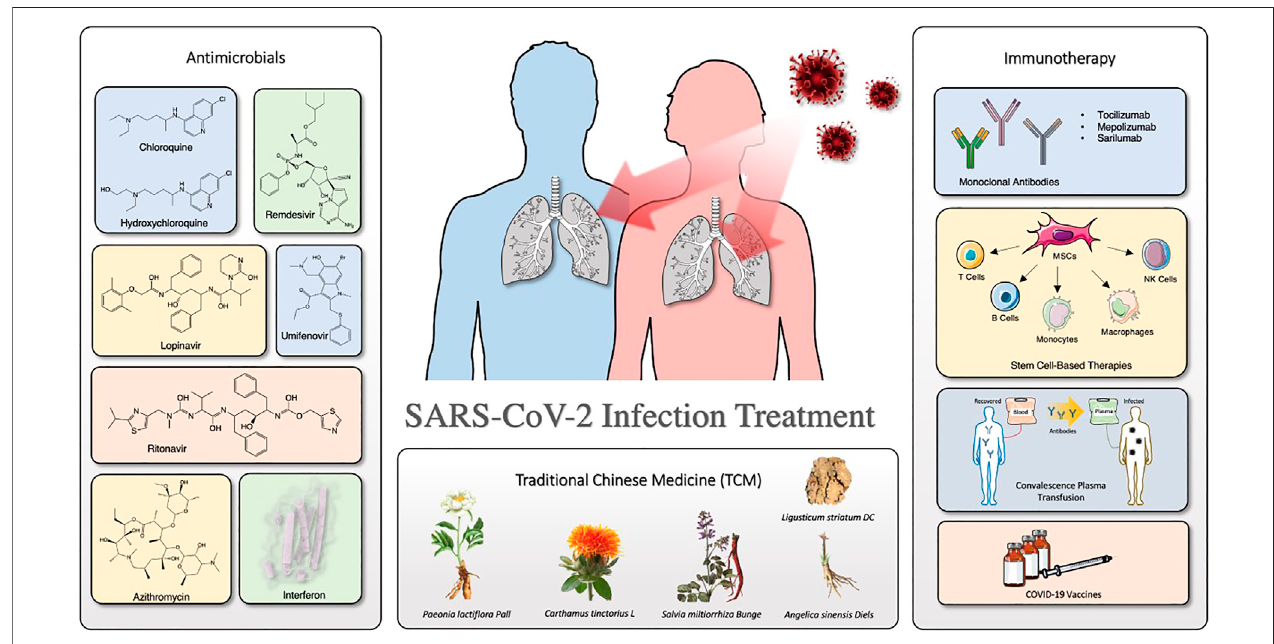
FIGURE 1 | Overview of the organization of this